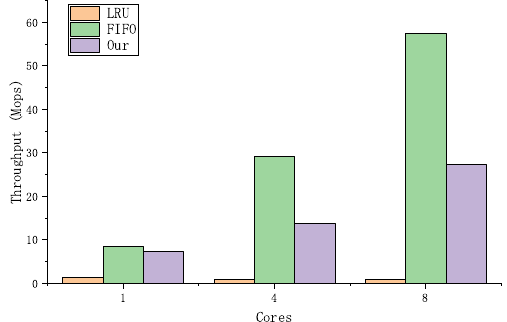
Figure 10. Throughput at 100% put operation.